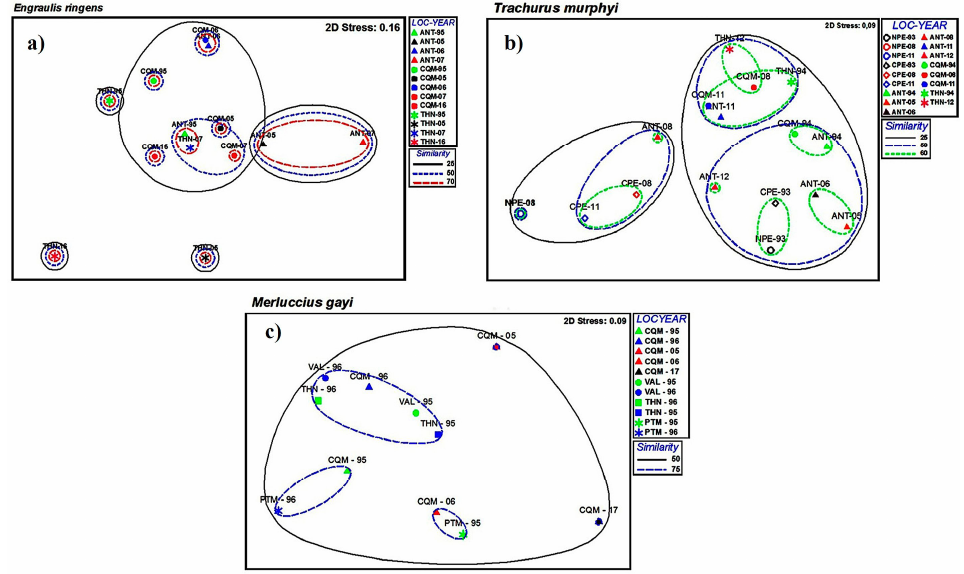
Figure 2. Non-metric multidimensional scaling (nMDS) of parasite communities in three fish species in the southeastern Pacific Ocean: ( a ) E. ringens ; ( b ), T. murphyi ; ( c ), Merluccius gayi . Circles represent similarity levels between samples of